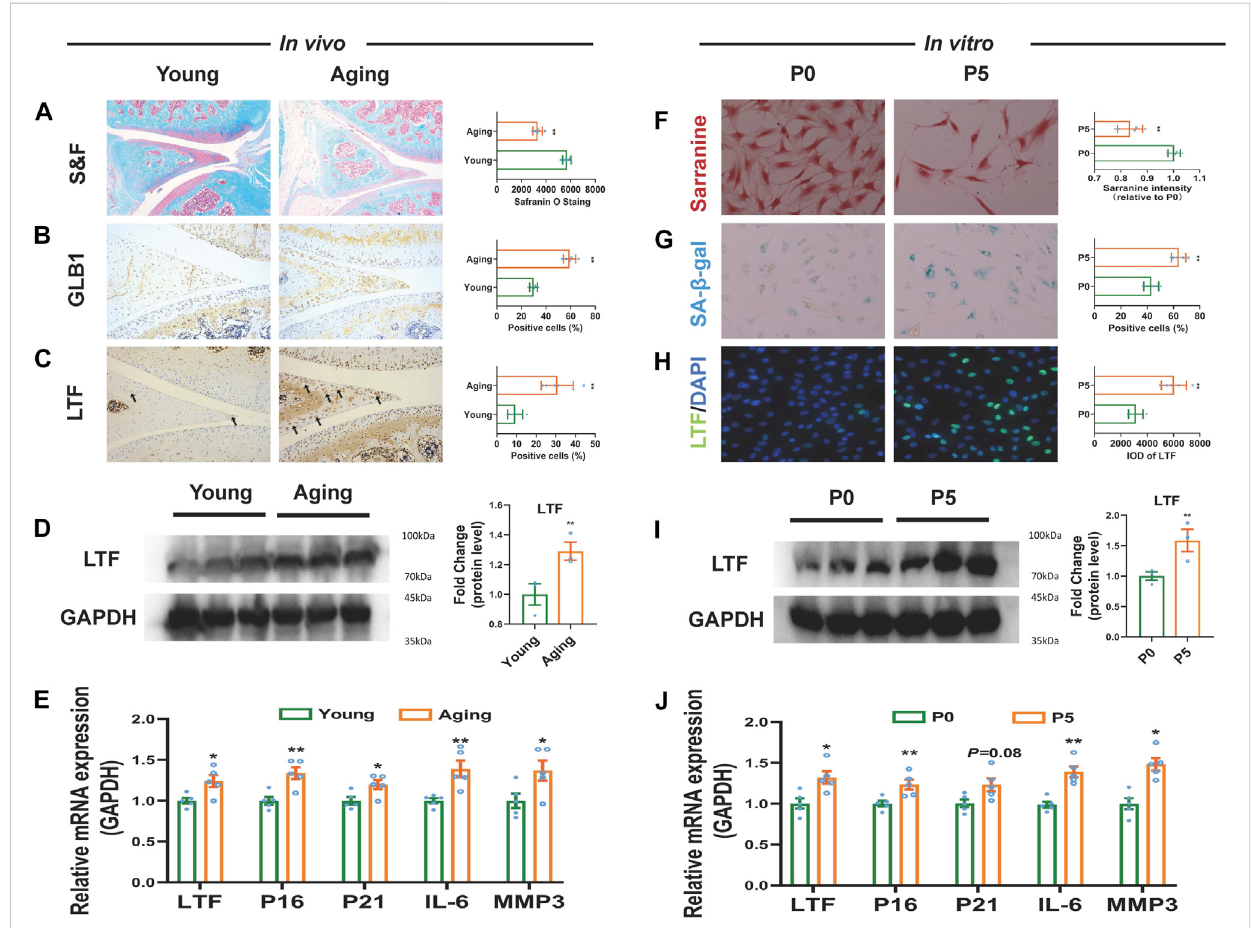
FIGURE 5 The expression of LTF in aged meniscal tissues and senescent meniscal cells of rats. (A) Representative images and quantitative analysis of Safranin- O Fast staining in vivo , scale bar = 50 μ m, n = 5. (B, C) Representative immunohistochemistry images and quantitative analysis for GLB1 and LTF in vivo , scalebar=50 μ m,n=5. (D) LTFproteinexpression invivo ,n=3. (E) ThemRNAexpressionofLTF,P16,P21,IL-6andMMP3 invivo ,n=5 (F) Representative images and quantitative analysis of Safranin-O staining in vitro , scale bar = 50 μ m, n = 5 (G) Representative images and quanti fi cation of SA- β -Gal positive cells of SA- β -Gal staining in vitro , scale bar = 50 μ m, n = 5 (H) Representative images and quantitative analysis of immuno fl uorescence for LTF in vitro , scale bar = 50 μ m, n = 5 (I) LTF protein expression in vitro , n = 3 (J) The mRNA expression of LTF, P16, P21, IL-6 and MMP3 in vitro . Mean ± S.E.M., * p < 0.05, ** p < 0.01 compared with control groups. S&F, safraninO-Fast green; GLB1, galactosidase beta 1; LTF, lactotransferrin;SA- β -Gal, senescence- associated β -galactosidase; P16 (CDKN2A), cyclin dependent kinase inhibitor 2A; P21 (CDKN1A), cyclin dependent kinase inhibitor 1A; IL-6, interleukin 6; MMP3, matrix metallopeptidase